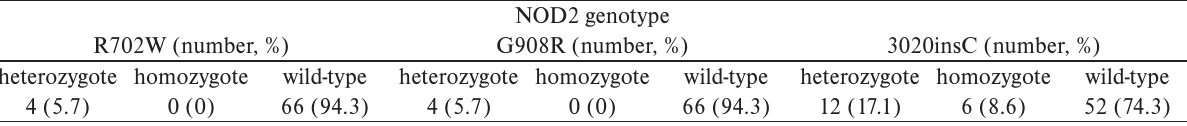
Table 2. NOD2 genotype in patients with Crohn’s